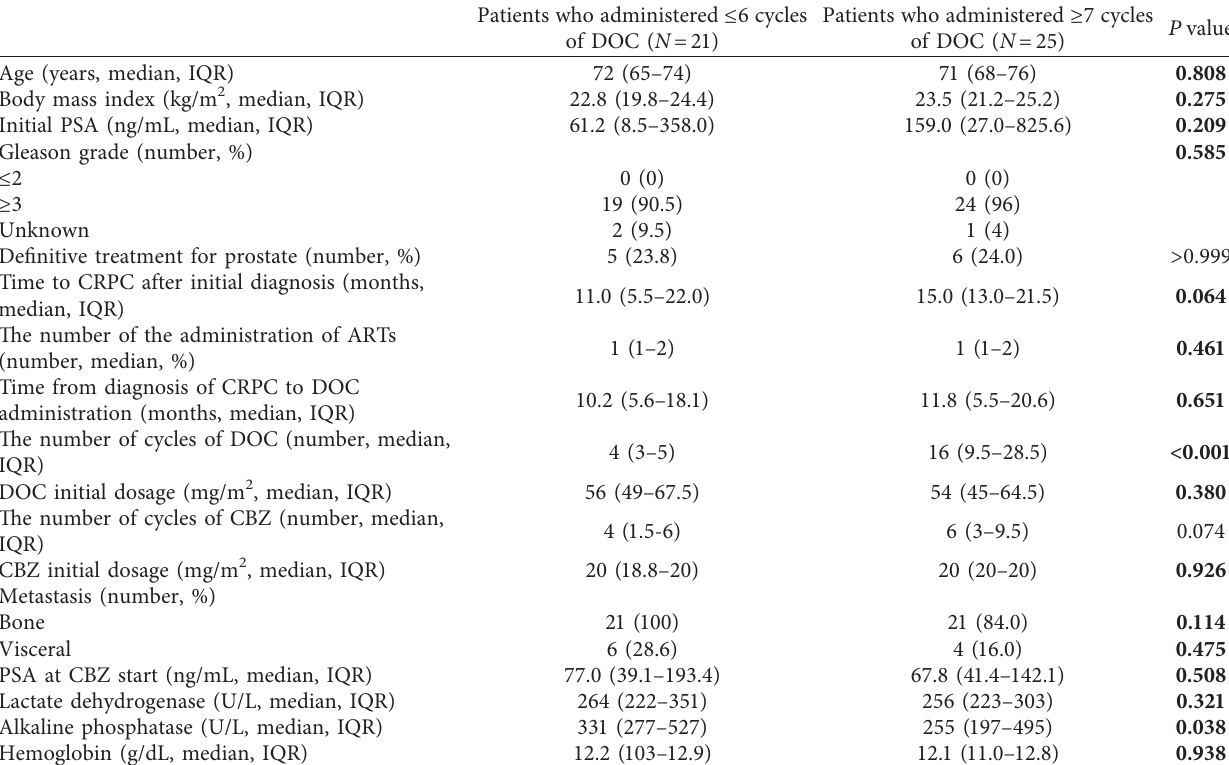
Table 2: Patients’ characteristics according to the number of cycles of